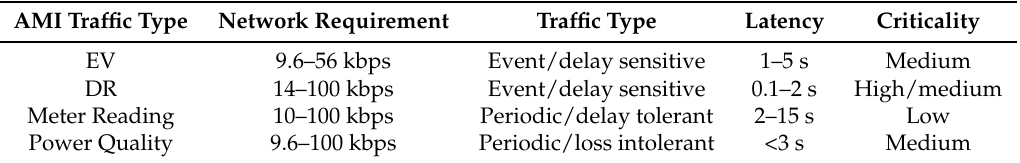
Table 4. Summary of the QoS requirements of AMI traffic types [5,34,35]. DR: demand